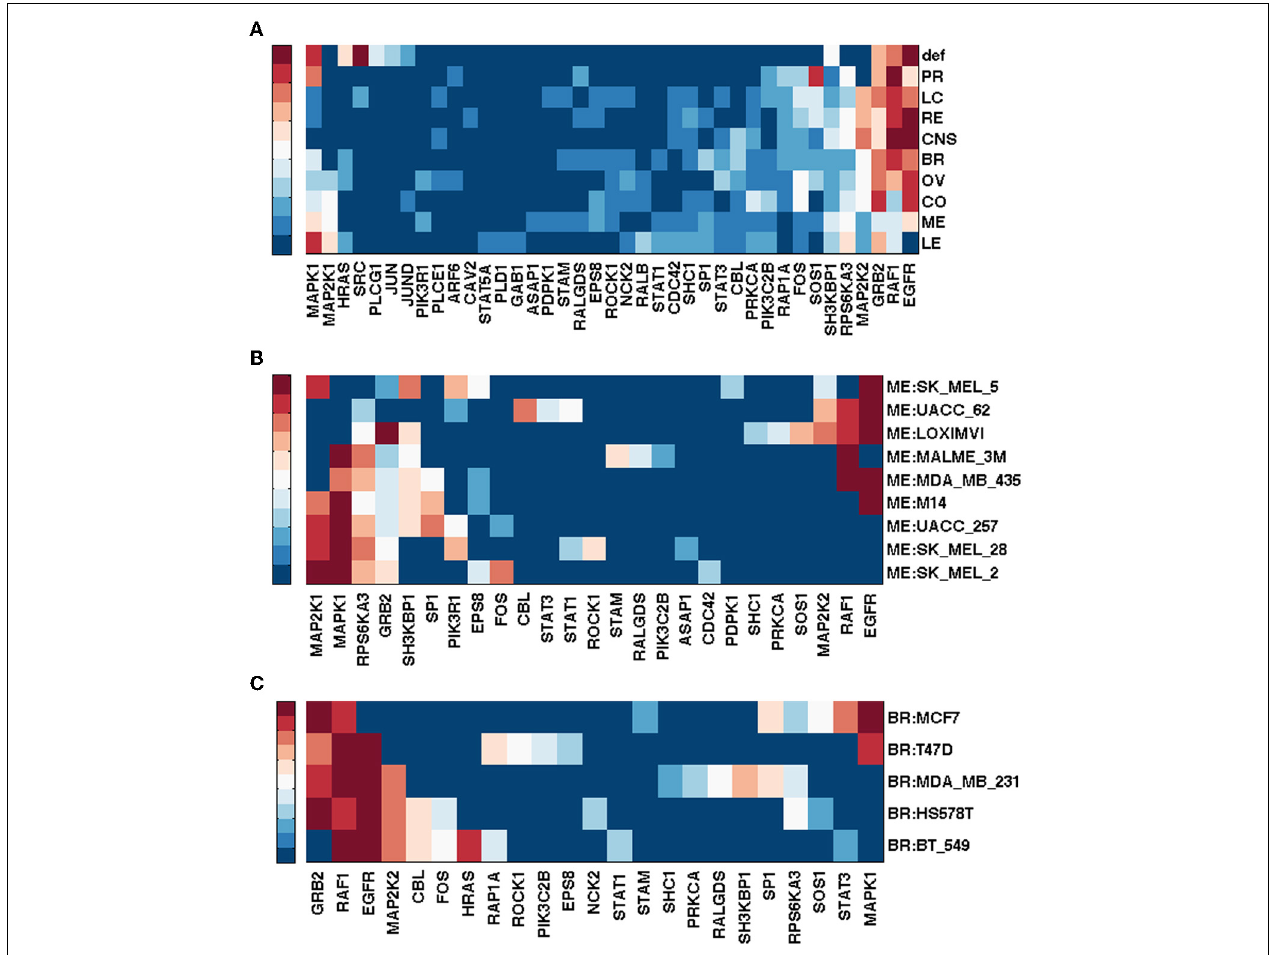
FIGURE 1 | Top ranked genes by spectral gap centrality with node removal c r s ( h = 2 ) of EGFR pathway conditioned on NCI60 cell line gene expression. Ranks range from 1 (dark red) to 10 (blue), and > 10 (the darkest blue). (A) Rankings are averaged for each tumor type: BR, breast; CNS,